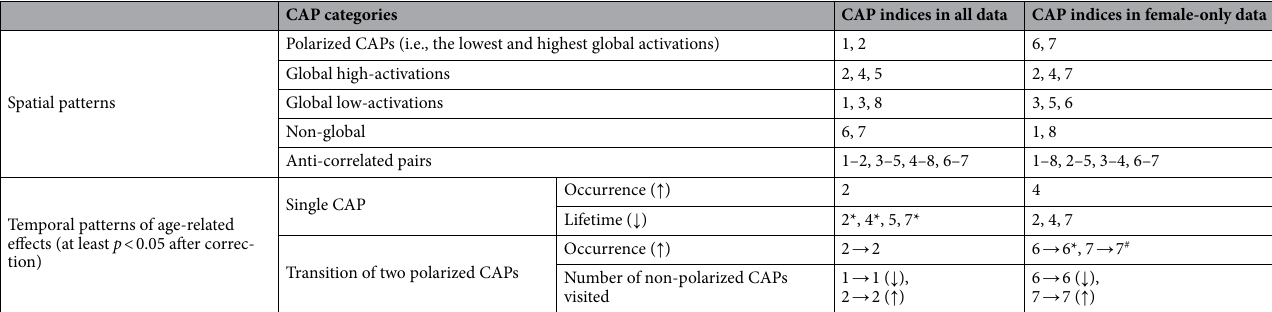
Table 1. CAP groups defined based on spatial patterns and the summary of major age-related CAP temporal patterns from both all data and female-only data. *Not survived with FDR or Bonferroni correction ( p < 0.05 before correction); #: approaching significance ( p = 0.058) before FDR correction.